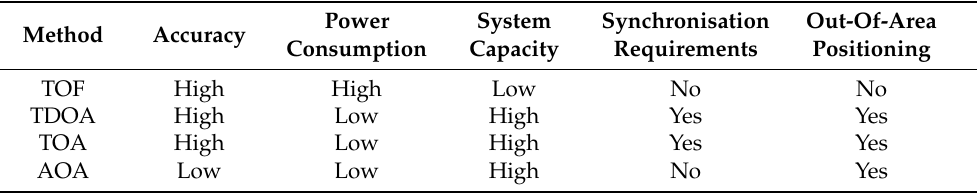
Table 4. Overview and Comparison of Positioning